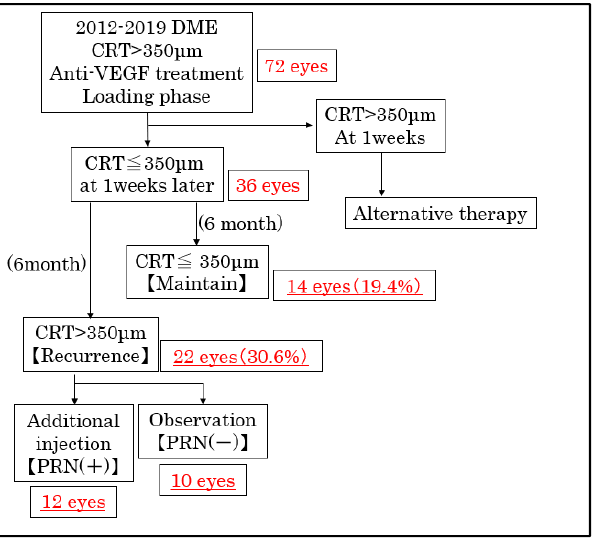
Figure 1. Flow chart describing the selection of the study population. CRT: central retina thickness; DME: diabetic macular edema; PRN: pro re nata.